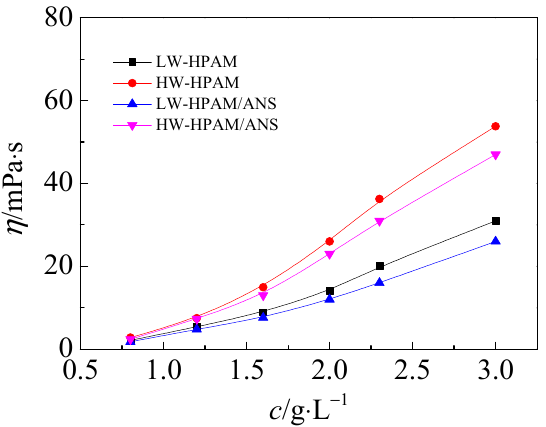
Figure 18. Dependence of viscosity ( η ) for aqueous HPAM solutions with and without ANS at anHPAM concentration ( c ) at the shear rate of 7.34 s − 1 . c ANS = 3.0 g ⋅ L − 1 . T = 85 ° C.